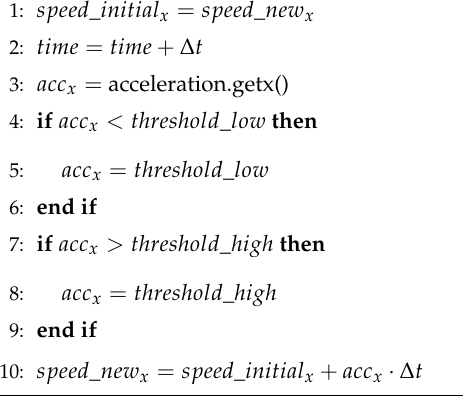
Algorithm 1 Computation of speed along the x